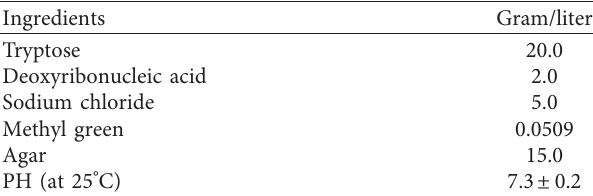
Table 9: Composition of DNase agar used in the study.